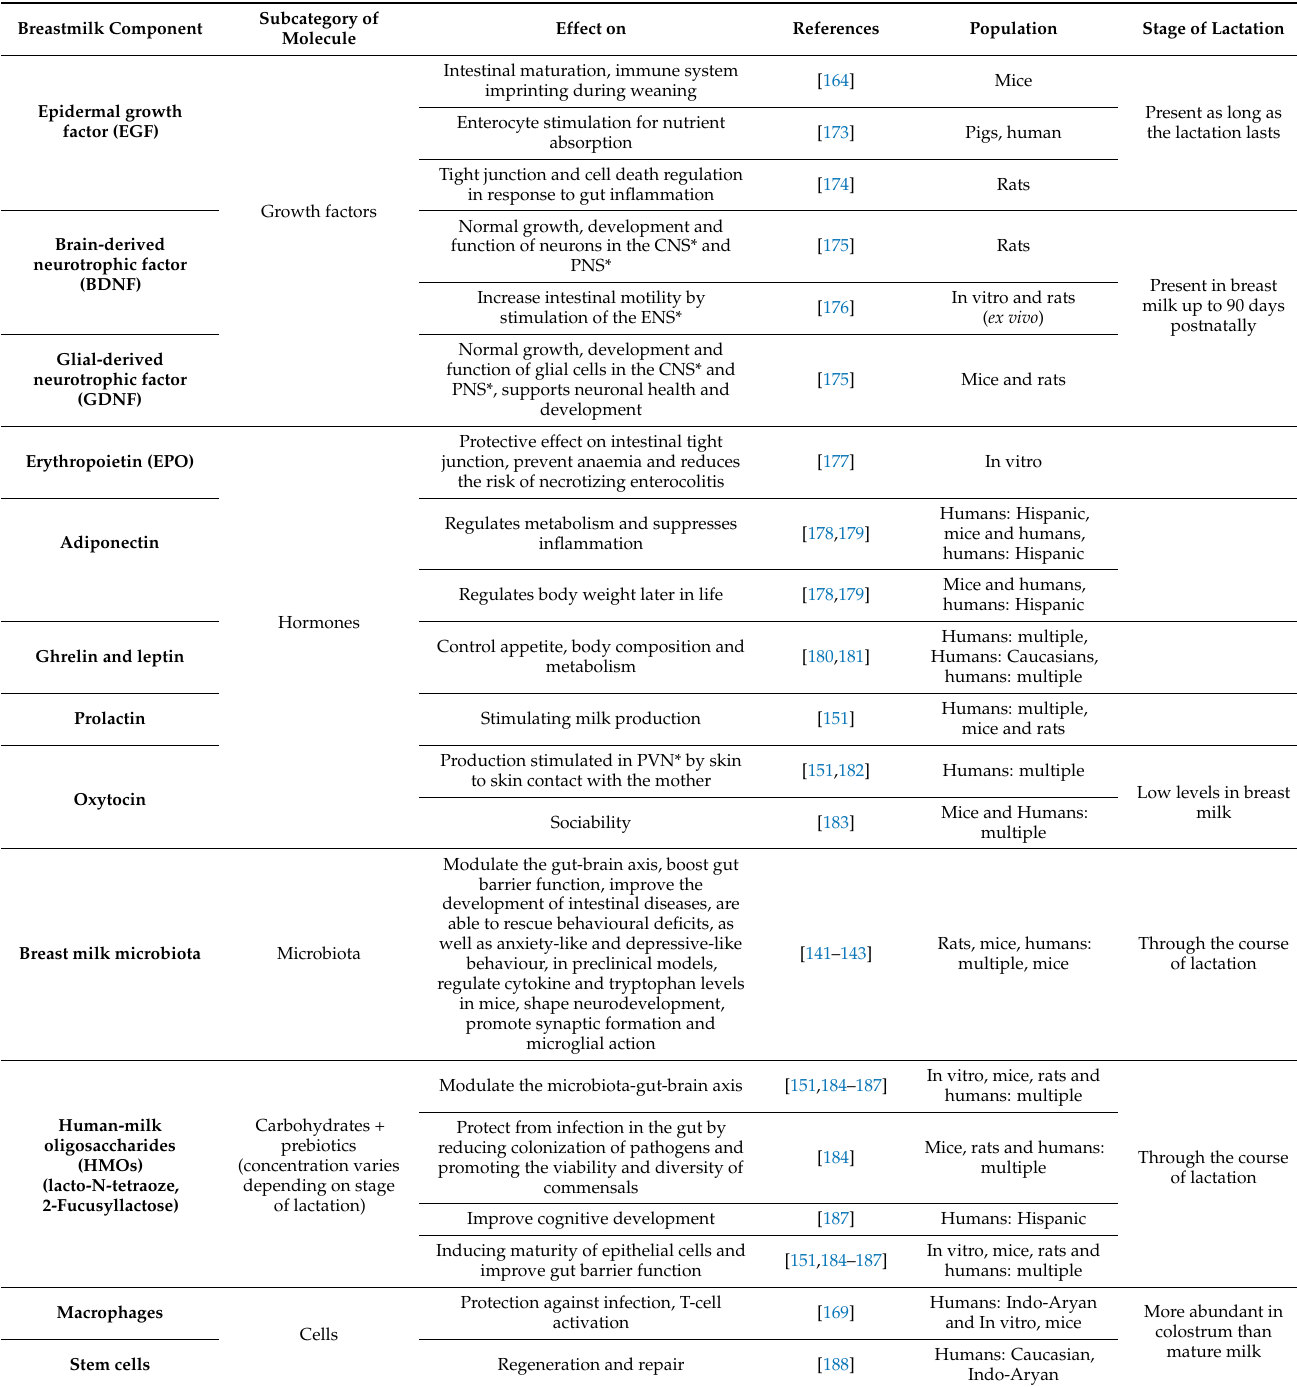
Table 3. Bioactive components of human milk and their effect on infant